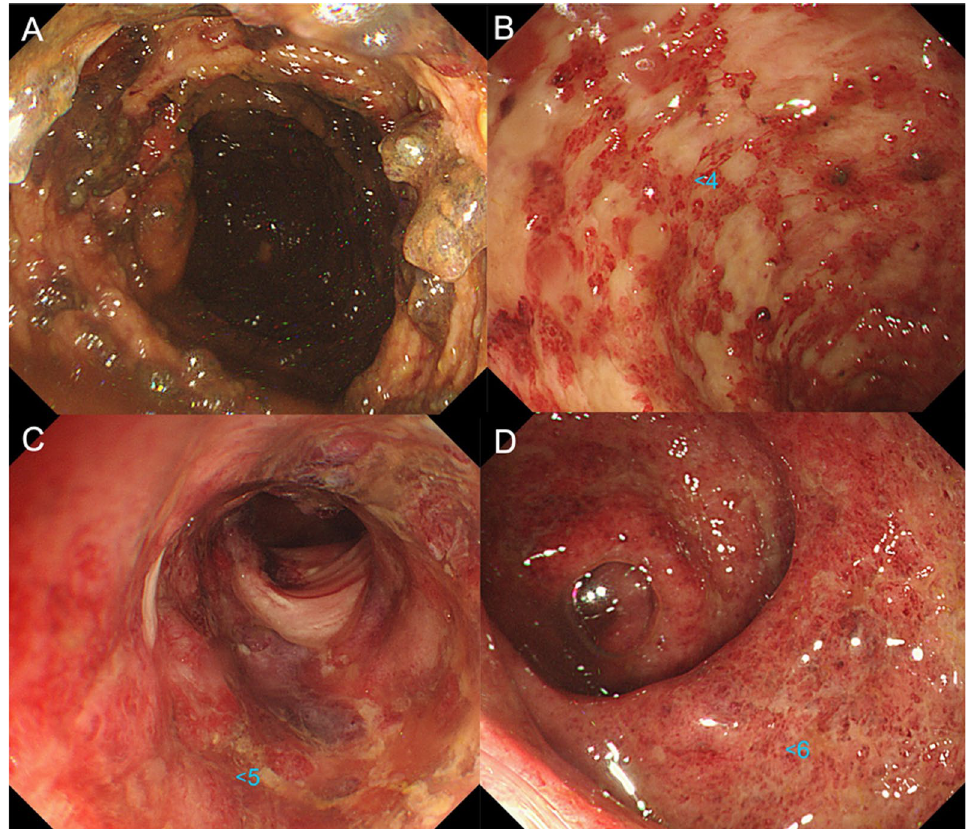
Fig. 1 Colonoscopy showing extensive ulceration of the ascending to descending colon and deep-seated ulceration of the sigmoid colon: A ascending colon, B descending colon, C sigmoid colon, D